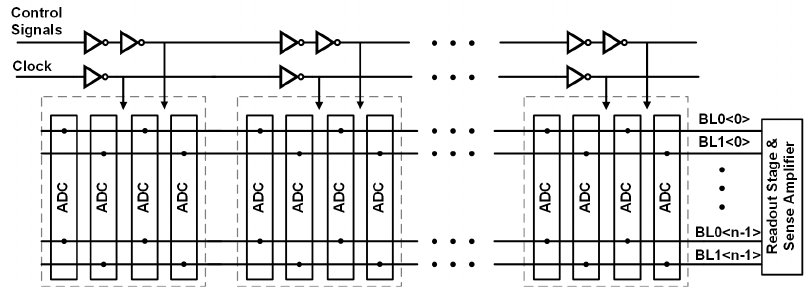
Figure 17. Diagram of the group delay scheme.